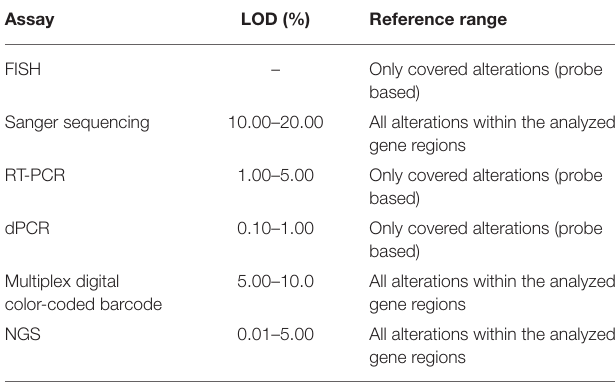
TABLE 1 | Overview of currently available molecular assays. Assay LOD